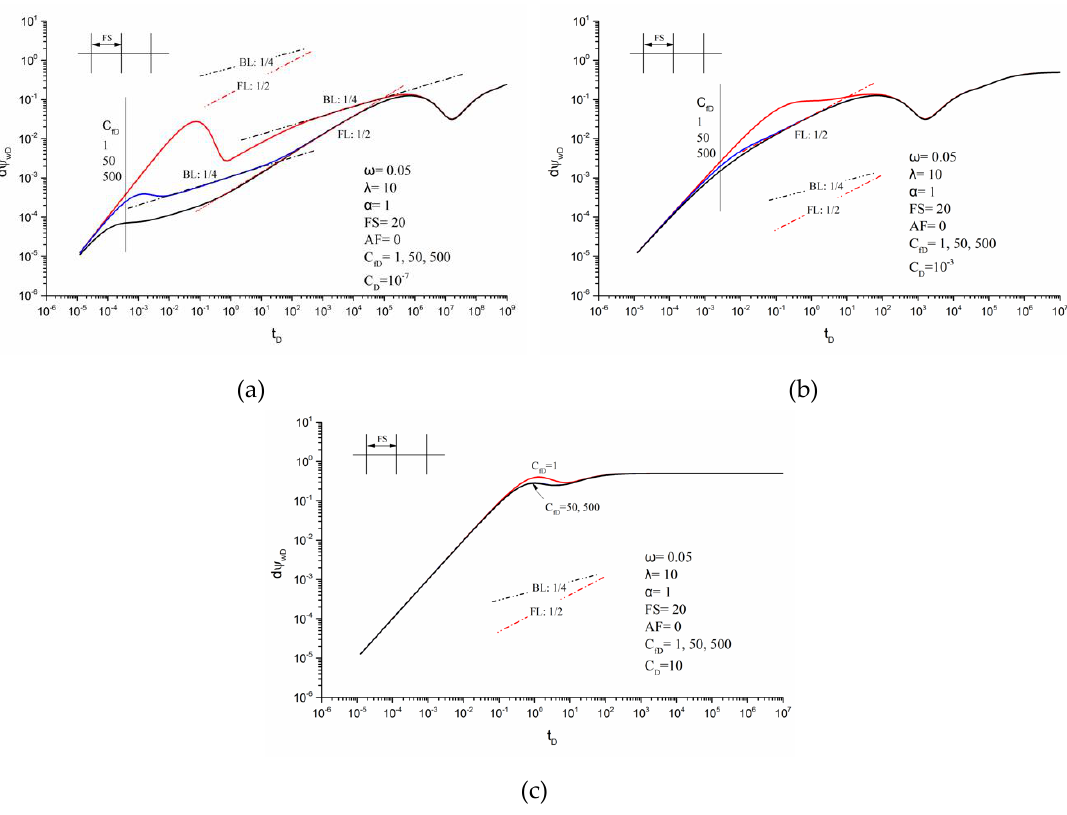
Figure 13. The e ff ect of wellbore storage on the pseudo-pressure responses. ( a ) Low wellbore storage; Figure 13. The effect of wellbore storage on the pseudo-pressure responses. (a) Low wellbore storage; ( b ) intermediate wellbore storage; ( c ) high wellbore (b) intermediate wellbore storage; (c) high wellbore storage.